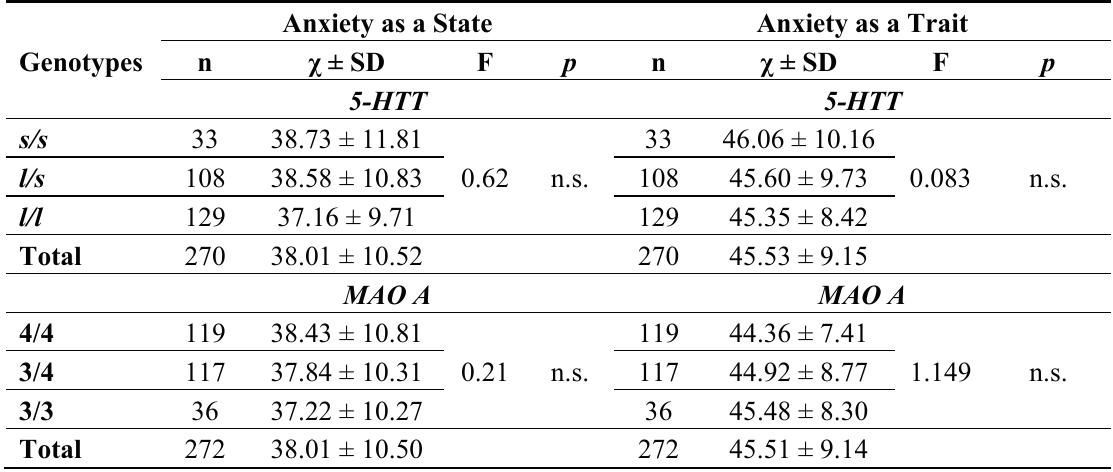
Table 1. Basic descriptive statistics concerning anxiety as a state according to STAI X-1 and anxiety as a trait, according to STAI X-2 of the 44-bp polymorphism in the 5-HTTLPR (SLC6A4) promoter region and of the 30-bp VNTR polymorphism in the MAO A promoter region among women in the